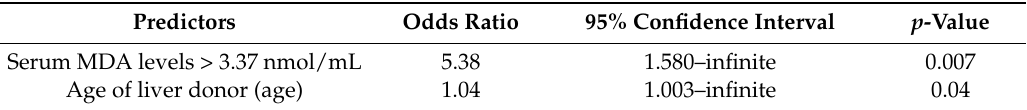
Table 3. Exact binary logistic regression analysis to predict mortality at 1 year after liver transplantation for hepatocellular